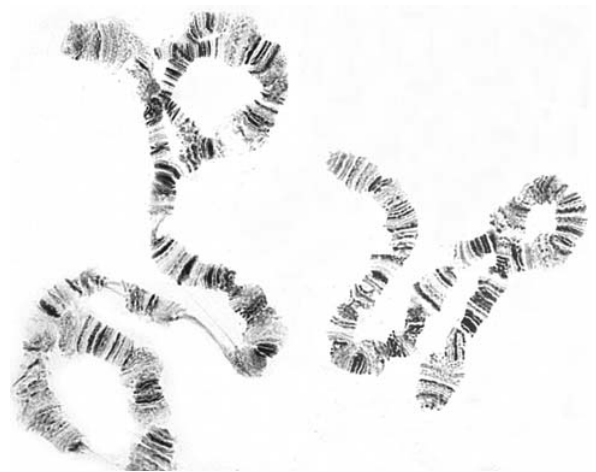
Figure 13 - Photomicrograph of an undetermined heterozygous arrange- ments found in D. arassari chromosome 3. Refer to the text for discussion regarding chromosome analyses.